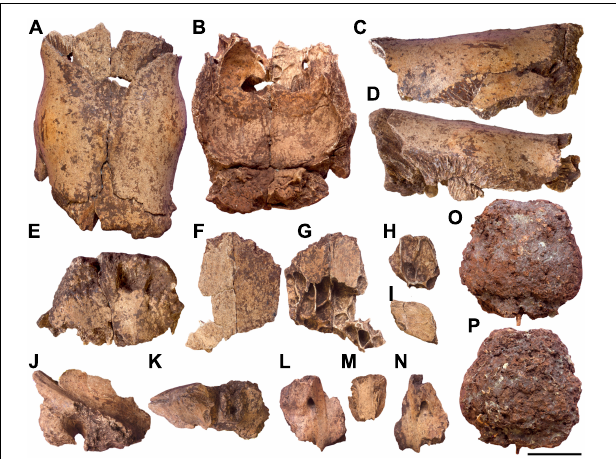
FIGURE 2 | Rhinocerotinae from Melpignano. Braincase MPND1082 in dorsal (A) , ventral (B) , left lateral (C) , right lateral (D) , and occipital (E) views; largest isolated fragment of the frontals in dorsal (F) and ventral (G) views; smallest isolated fragment of the frontals in ventral (H) view; fragment of the right parietal in dorsal (I) view; right temporal in right lateral (J) and ventral (K) views; fragmented basisphenoid in ventral (L–N) view. Natural brain endocast MPND1083 in dorsal (O) and ventral (P) views. Scale bar 5